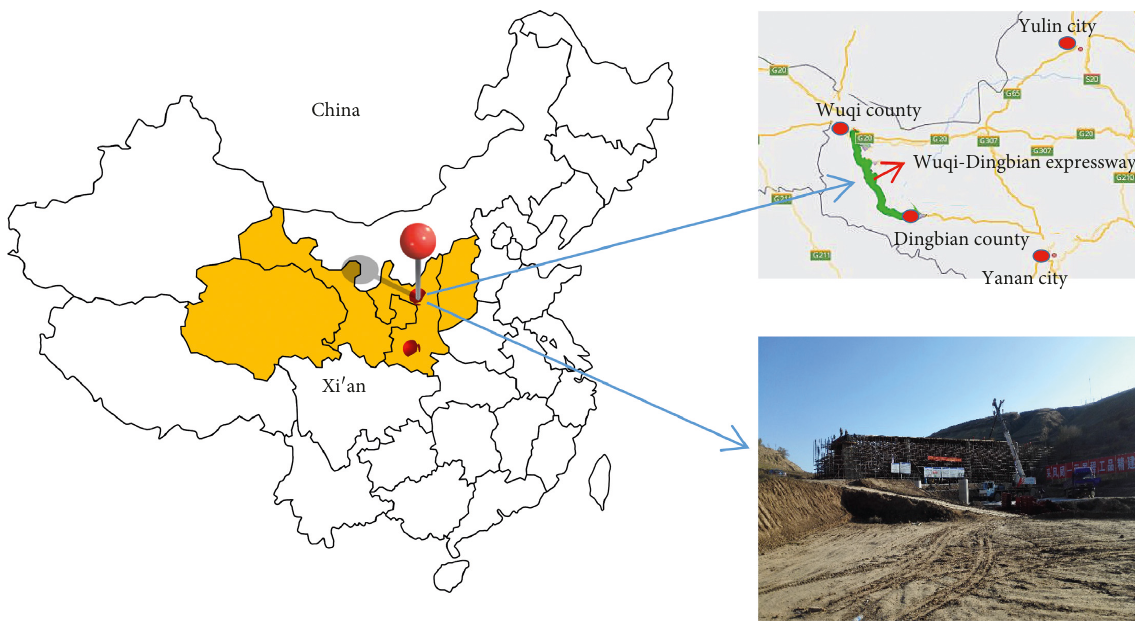
Figure 1: The approximate location of the test area (map data © 2018 Baidu maps; loess area distribution © Baidu encyclopedia; the picture was taken by Zhijun